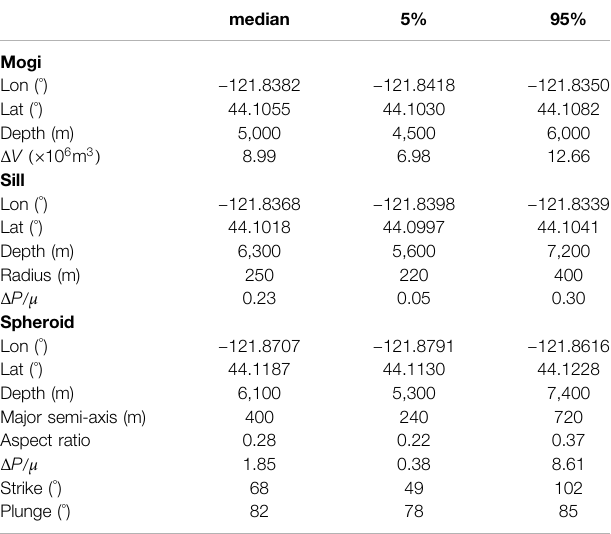
TABLE 2 | Bayesian inversion results, with the median a posterior probability solution and the 95% credible intervals, for the Elastic half-space Spherical Point Pressure (Mogi, 1958), Penny-shaped sill-like (Fialko et al., 2001) and Spheroid (Yang et al., 1988) deformation